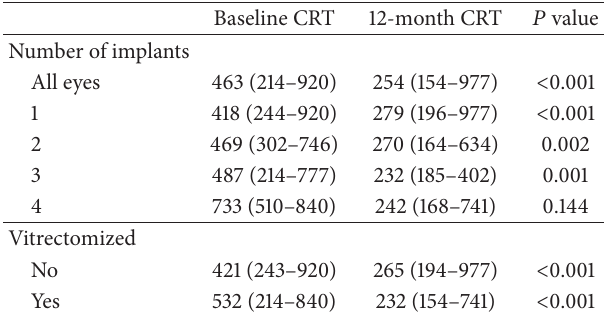
Table 5: Subgroup analyses of baseline and 12-month BCVA levels and CRT on OCT images by disease.